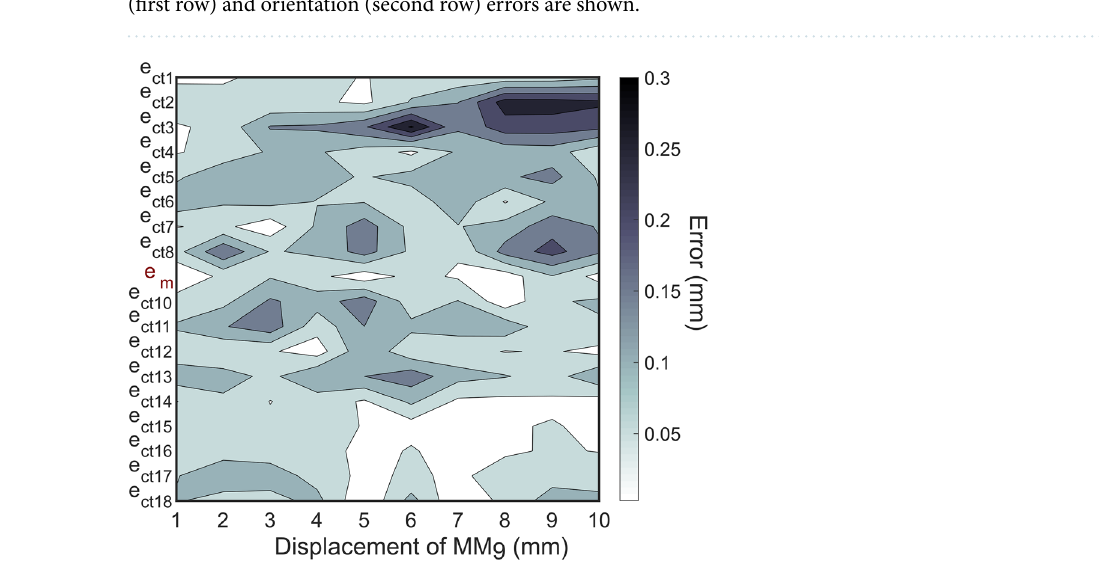
Figure 4. Contour plot showing the position displacement error matrix for 18 MMs (θ = 51°). The localizer was able to accurately retrieve the position of the moving magnet (i.e., MM 9 ) with a maximum e m of 0.1 mm. Pointwise e ct for all non-moving MMs proved always lower than 0.31